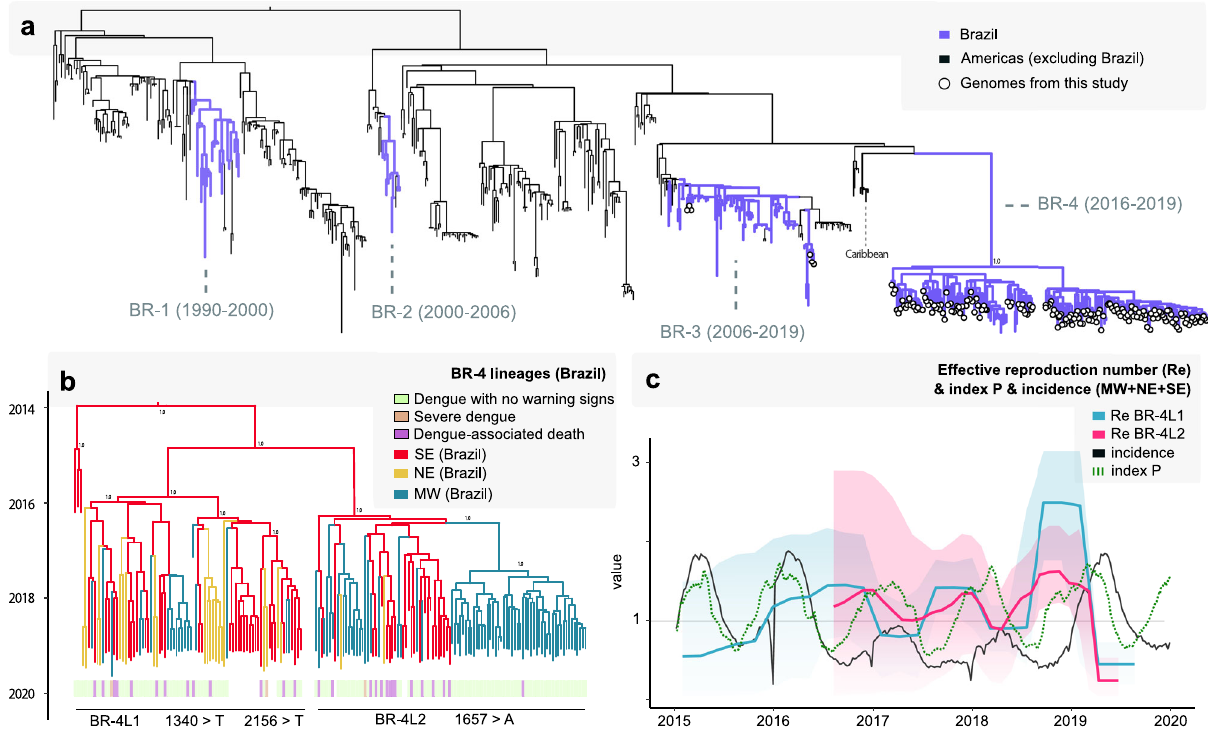
Fig. 3 Phylogenetic analysis of DENV2-III in Brazil. a A maximum likelihood tree was inferred using 170 complete genome sequences from DENV2 generated in this study and 450 sequences publicly available, retrieved from GenBank. The scale bar is in units of nucleotide substitutions per site (s/s) and mid-point rooted. Tip circles represent the genome sequences generated in this study. b Time-scaled phylogeographic tree of DENV2 BR-4, including 164 new DENV2 sequences generated here and 17 publicly available data from the 2019 outbreak in Brazil 22 . Sequences are colored according to sampling location. Sidebars represent the dengue clinical classi fi cation for each sequenced sample. c Temporal fl uctuation of the effective reproduction number (R e ) of the for DENV2 BR-4L1 (blue) and BR-4L2 (magenta) estimated using the Bayesian birth-death approach. Black line is the total weekly incidence of dengue between 2015 and 2020 (until EW06), and the dotted green line is the index P (incidence is summed and index P is averaged over the three macro regions for which new sequences were generated: MW = Midwest, NE = Northeast, and SE = Southeast). Incidence (cases per 100 K population) is presented in log10 for visual